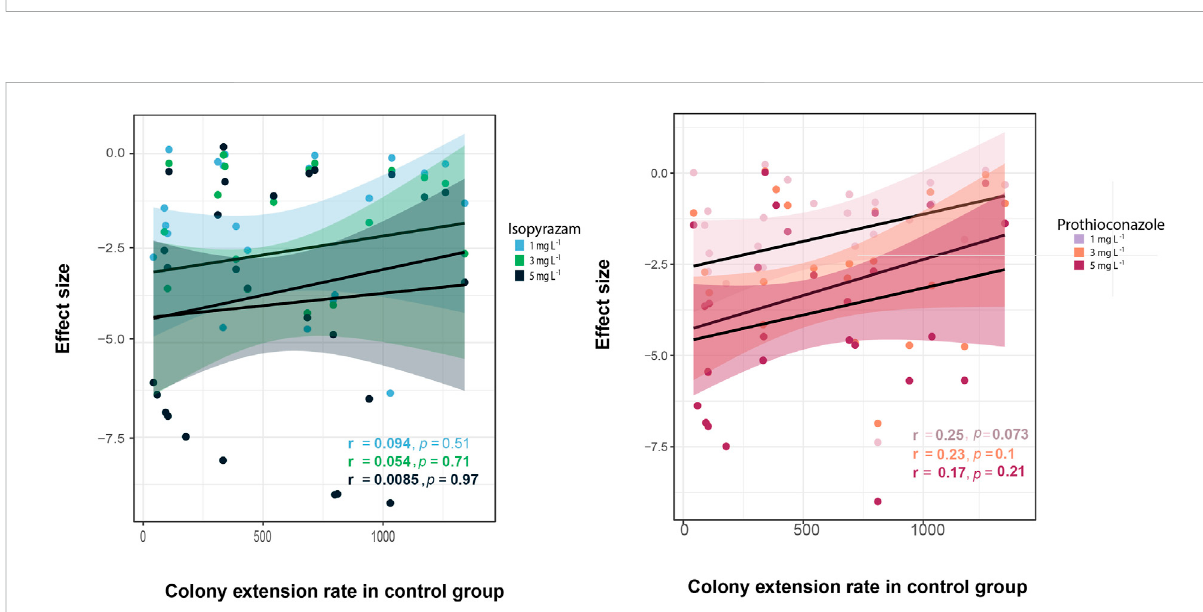
FIGURE 4 Correlation between the effects sizes of the fungicides and the colony extension rate (mm 2 · day − 1) in the control group. Dots represent effect sizes for individual isolates under certain concentration of isopyrazam (blue) and prothioconazole (light red). Increasing fungicide concentration is depicted by increasing color intensity. Linear regression (black lines) and con fi dence interval (colored band) in every treatment are presented. Correlation coef fi cients (r) and signi fi cance level ( p < 0.05) are included in each